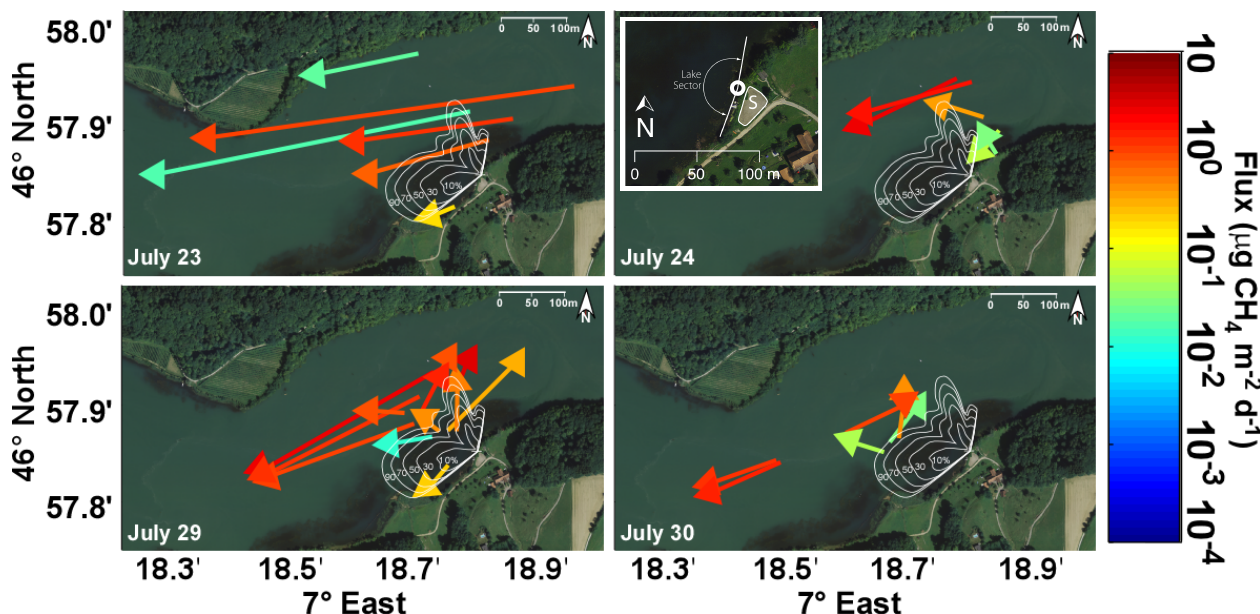
Fig. 6. Flux footprint for CH 4 efflux from Lake Wohlen and tracks (arrows) and mean efflux measurements (color) of floating chambers deployed on four days in 2008: 23 July (top left), 24 July (top right), 29 July (bottom left), and 30 July (bottom right). Isolines of eddy covariance flux footprints show percentage of contribution to flux measurements of both periods. Isolines are drawn for 10, 30, 50, 70, and 90% flux of the footprint area. The inset in upper right panel shows the lake sector and the sandbox (S) in greater detail. The white circle shows the position of the flux tower on the lake shore (background image © 2011 swisstopo, reproduced with the authorization of swisstopo